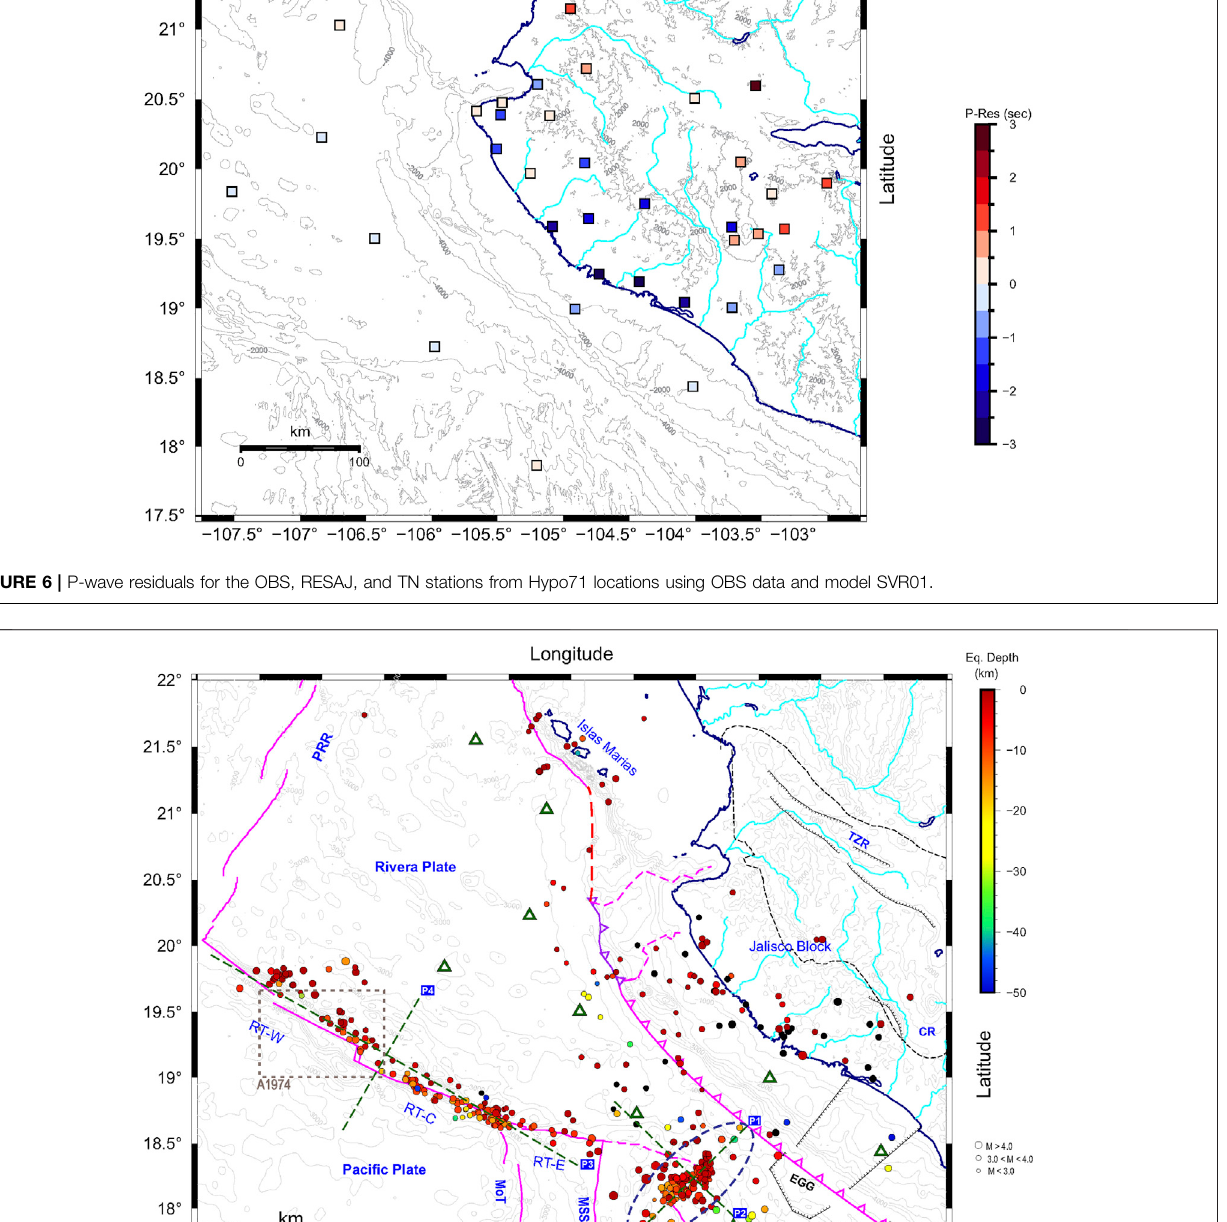
Frontiers in Earth Science |